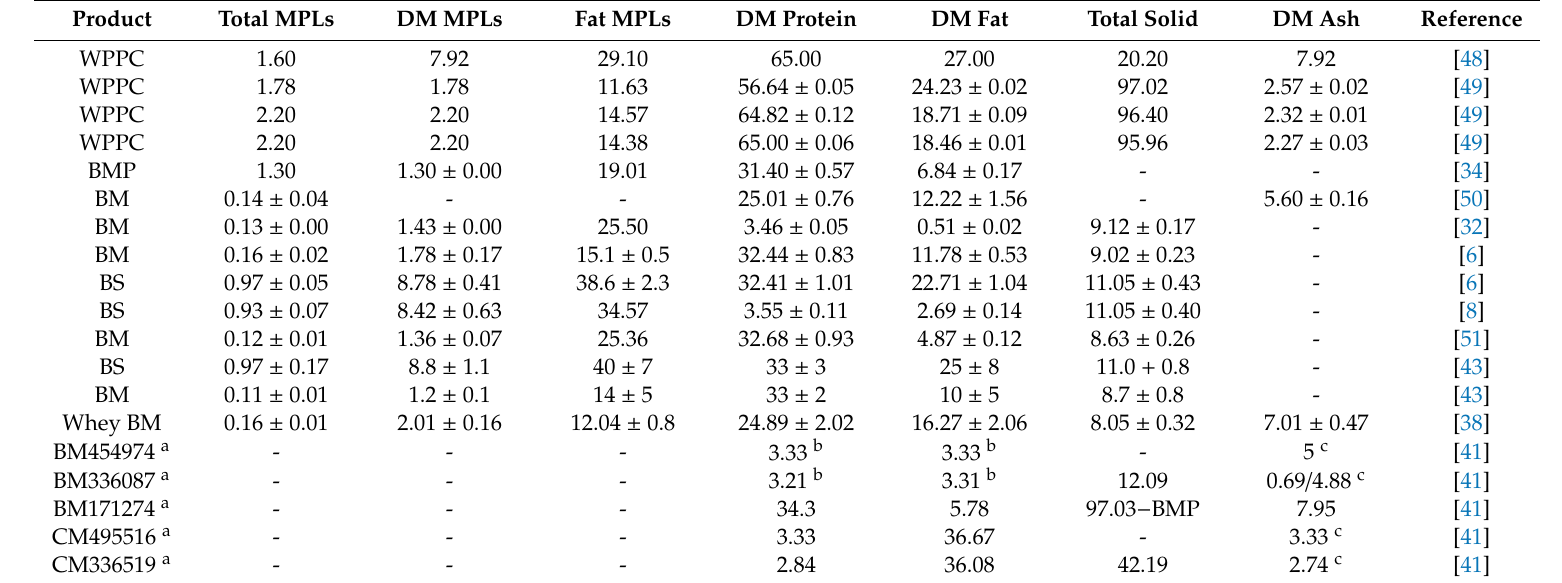
Table 1. Dairy product composition (g / 100